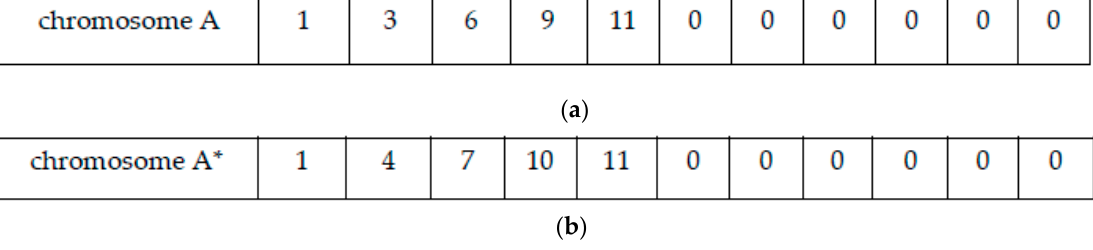
Figure 5. Operation diagram of chromosome mutation. ( a ) Chromosome A before mutation; and ( b ) chromosome A* after mutation.